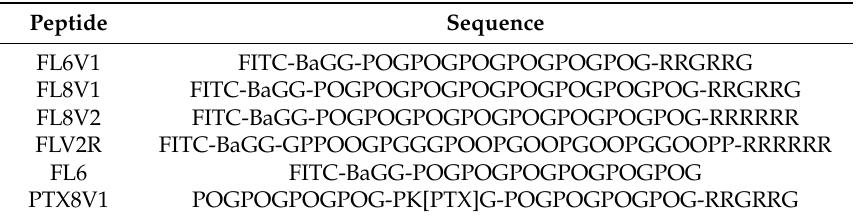
Table 1. Peptide sequences 1